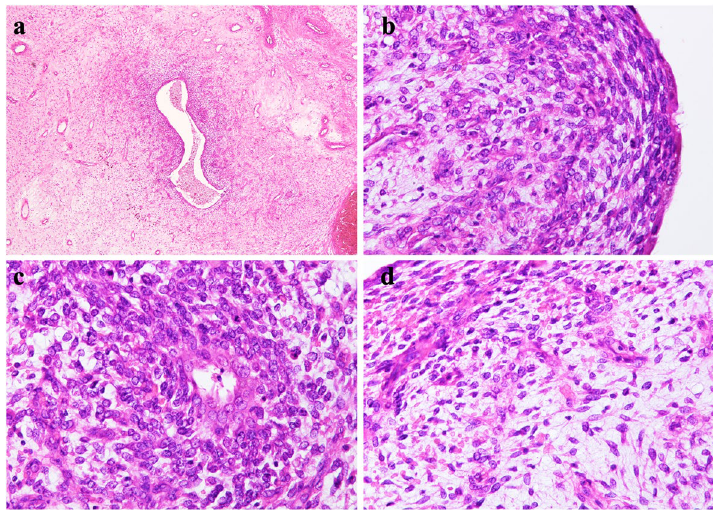
Fig. 3 a Tubular glandular lumen with high cell density around the gland. b Increased cell density under the epithelium. c Stromal cells showing nuclear enlargement with a high N/C ratio and scattered mitotic figures. d Edematous stroma observed in some